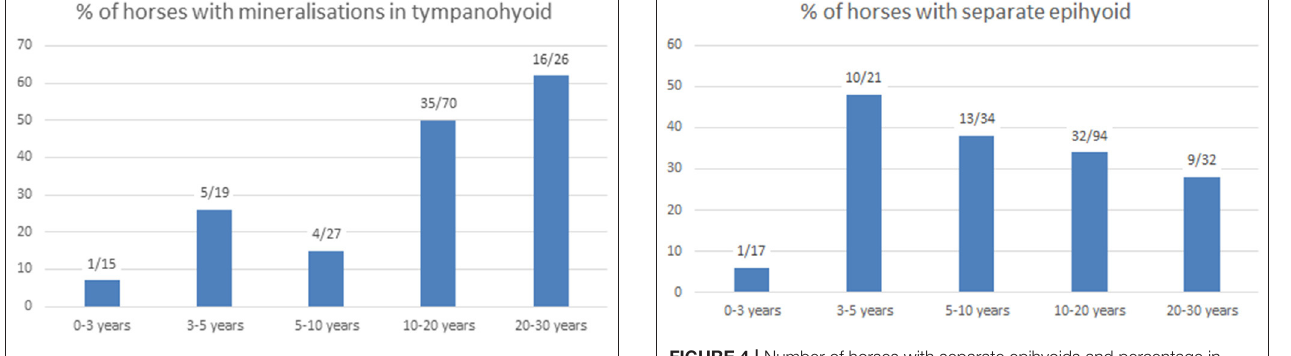
mineralization was very rare in horses between 0 and 3 years of age and was more frequent amongst older horses ( Figure 3 ).